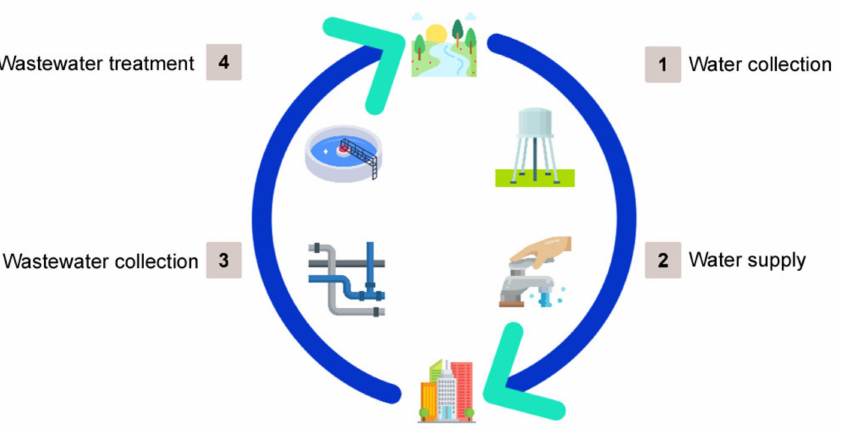
Figure 2. Urban water